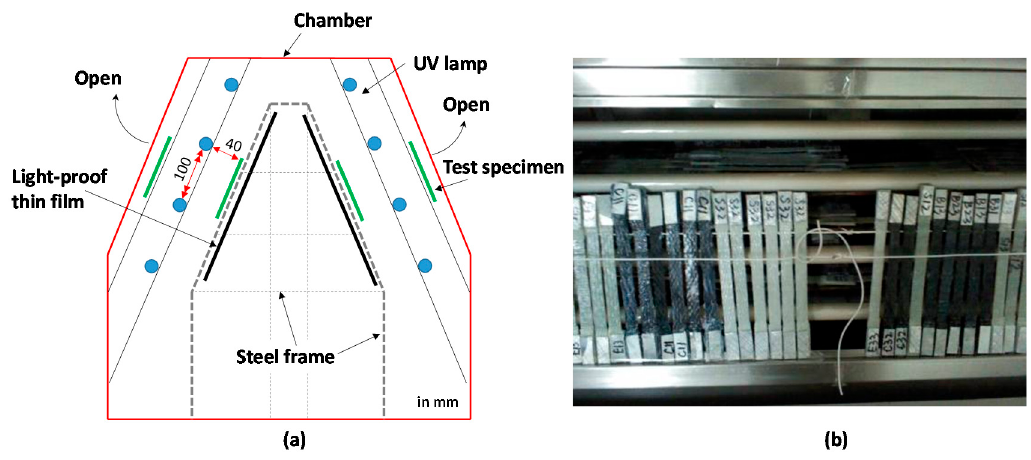
Figure 5. UV test chamber: ( a ) cross section and ( b ) arrangement of samples.